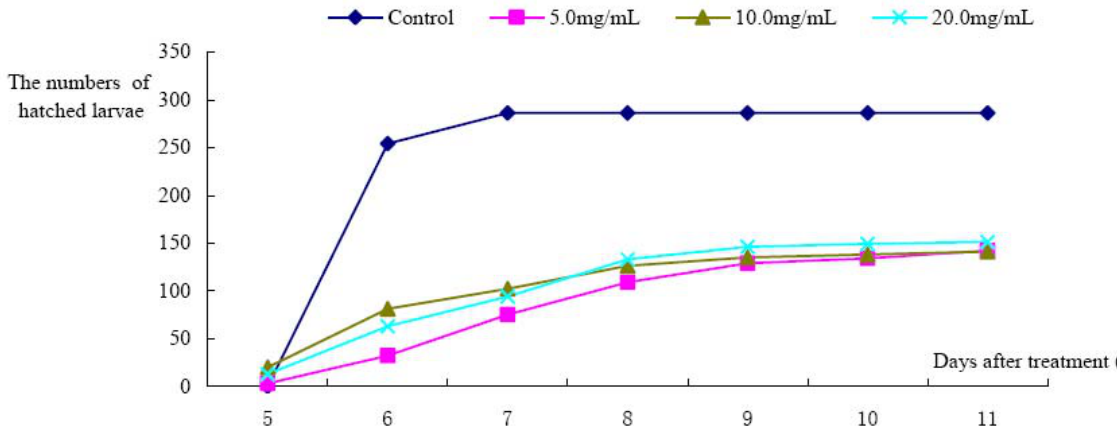
Figure 2. The numbere of hatched larva of M. separata caused by different concentrations of fraxinellone along with